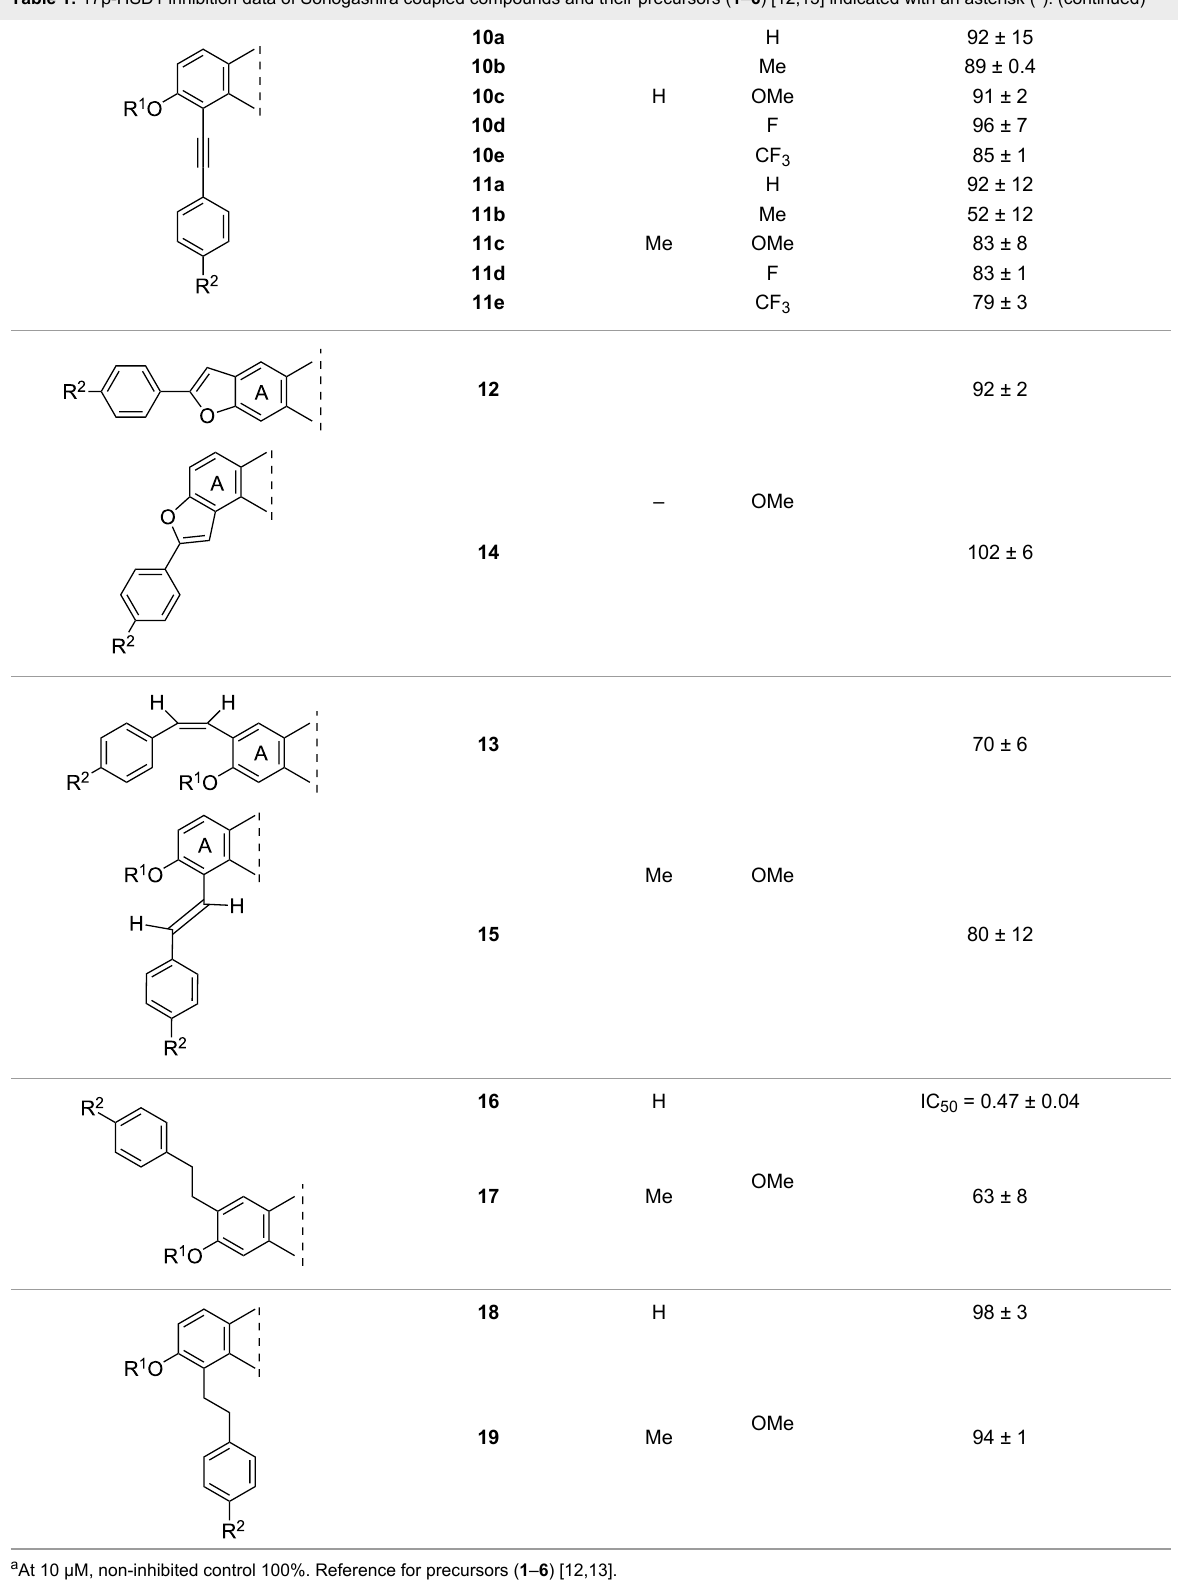
Table 1: 17 β -HSD1 inhibition data of Sonogashira coupled compounds and their precursors ( 1 – 6 ) [12,13] indicated with an asterisk (*).